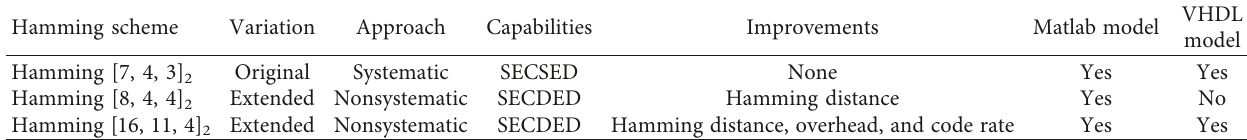
Table 9: Summary of developed codes.